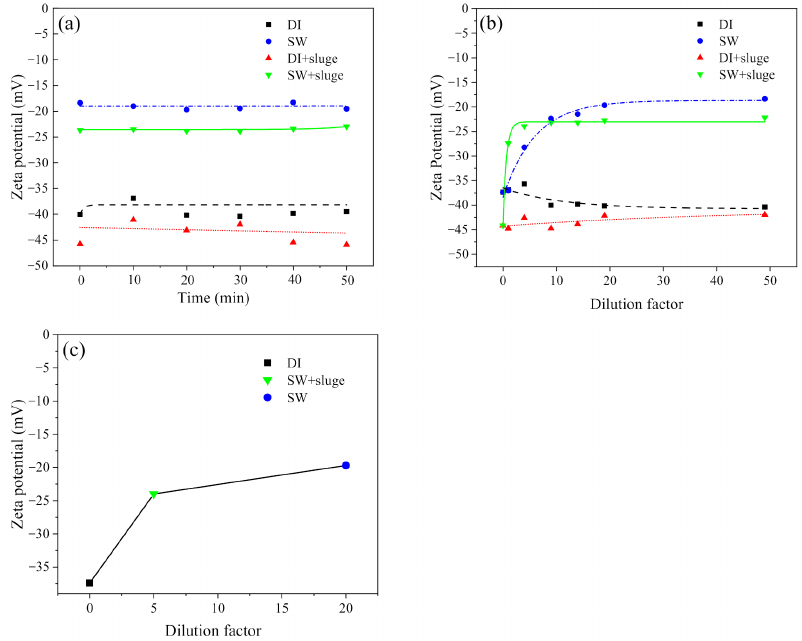
Figure 2. The effect of exposure time ( a ) and dilution at 220 min ( b ) on the ζ –potential changes after exposing cit–AgNPs (50 × dilution, 1.7 × 10 10 particles ml − 1 , 1.68 mg L − 1 ) in DI and SW, with or without sludge, respectively. The relationship between plateaued ζ –potential and the minimum dilution required to reach the plateau were shown in ( c ). Notes: pH and IS in SW was 8.7 and 100 mM, respectively. HA in sludge was 42 mg L − 1